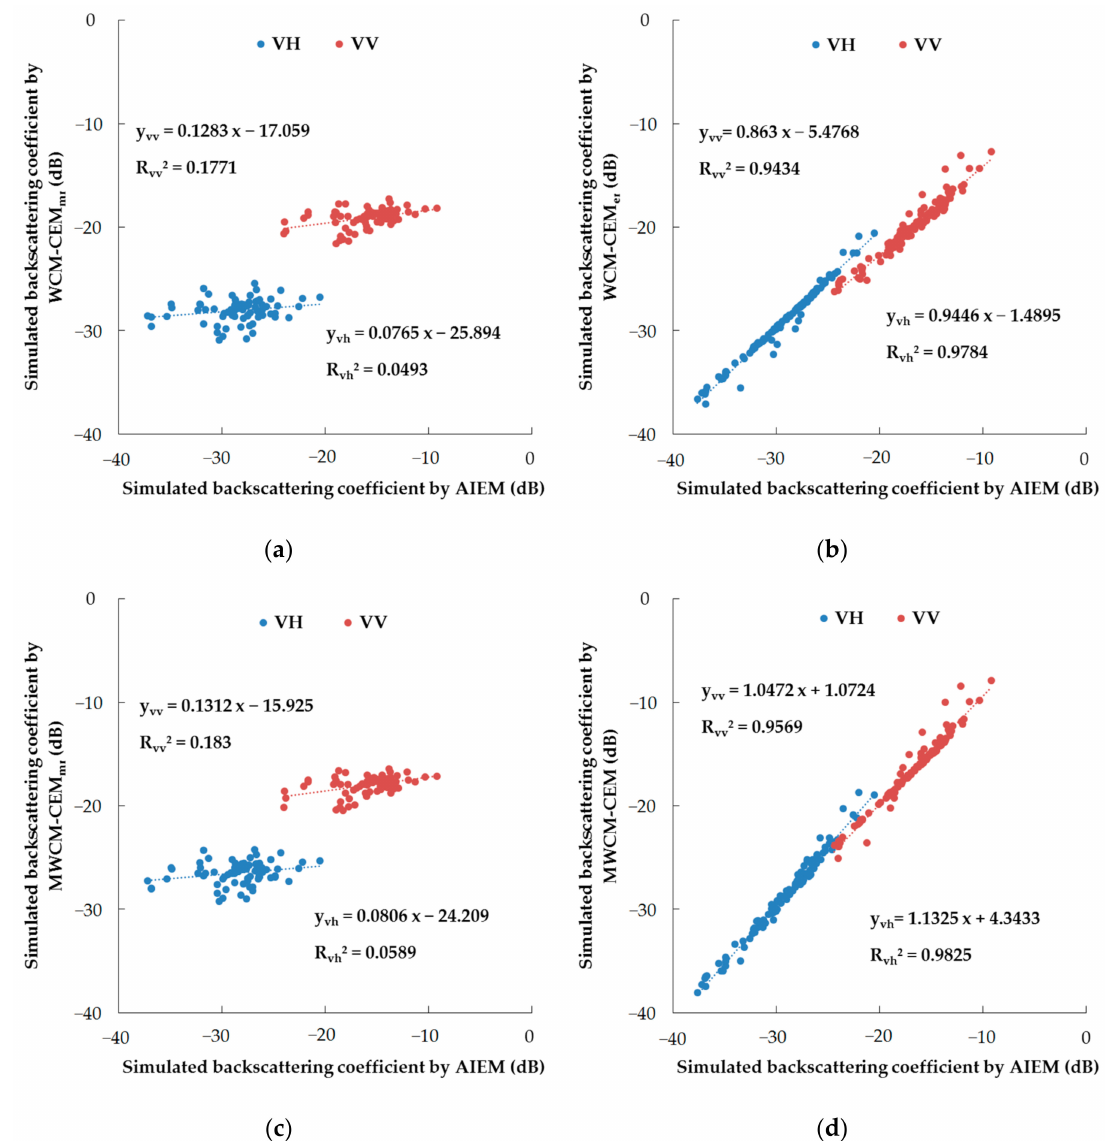
Figure 6. Comparison of simulated backscattering coefficients between AIEM and the four combinations: ( a ) WCM-CEM mr ; ( b ) WCM-CEM er ; ( c ) MWCM-CEM mr ; ( d )